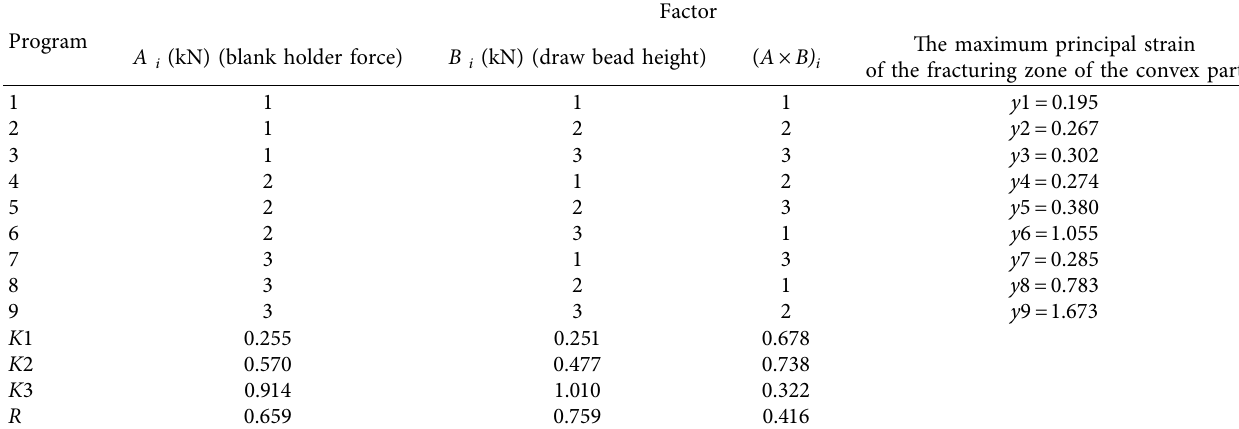
Table 2: Orthogonal experimental design